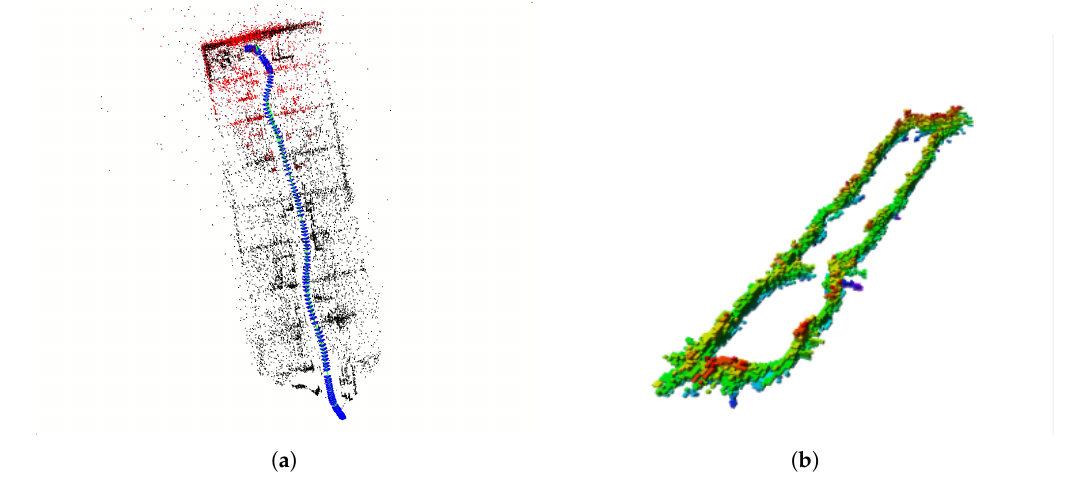
Figure 11. 3D point cloud map and octree map created for the warehouse. ( a ) Point cloud map; points in red color represent the keypoints in current optimization window; black represents the optimized keypoints; blue represents keyframes; and green is the edge between keyframes. ( b ) Octree map; the different color was set according to the height of